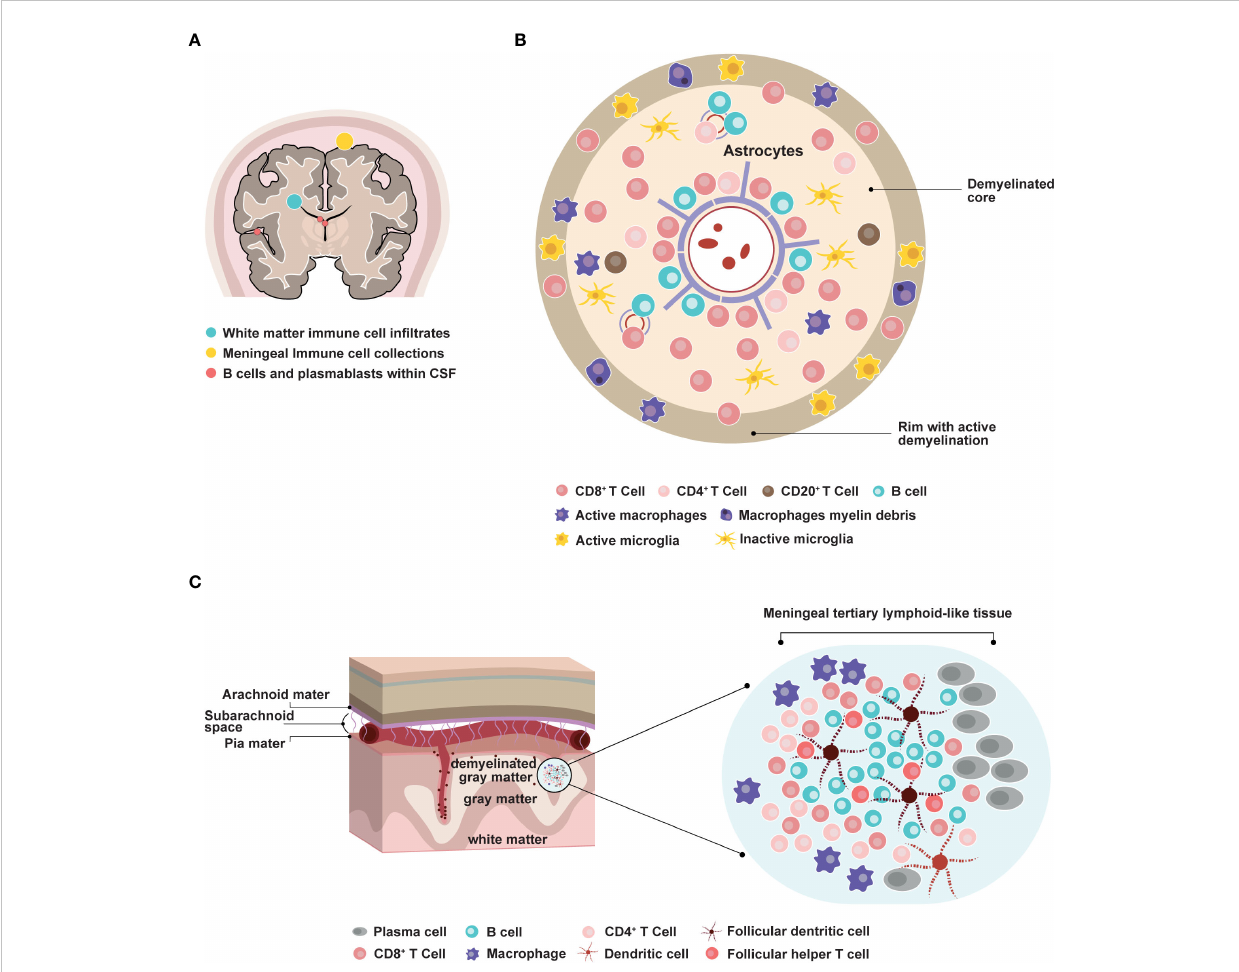
FIGURE 1 Involvement of B cells in multiple sclerosis pathophysiology. (A) Distribution of B cells in the central nervous system areas involved in MS pathology. CSF: cerebrospinal fl uid. (B) Representation of an active MS lesion with a central in fl amed vein, a demyelinated core, and a rim of active demyelination, and distribution of immune cell subpopulations (8, 9, 11, 17 – 20) (C) Representation of a meningeal follicle-like structure (17, 18, 21 –